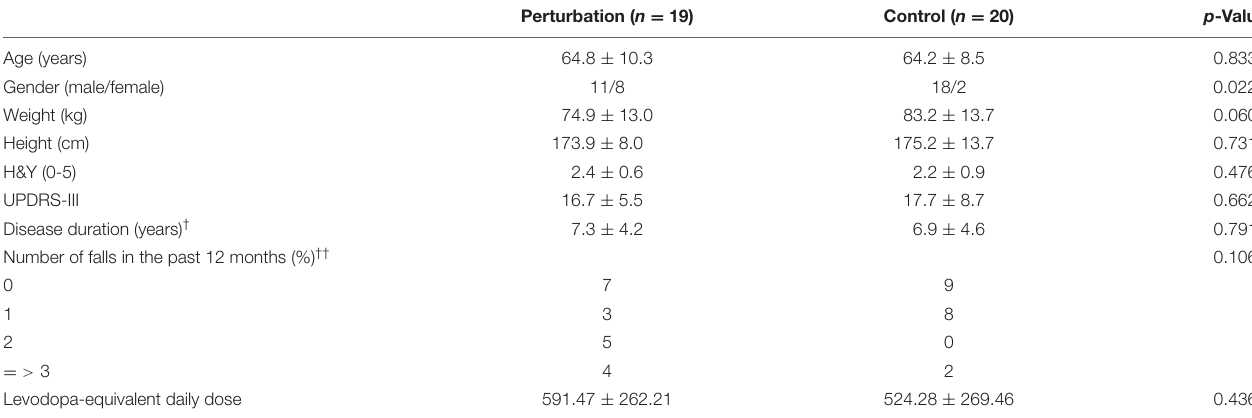
TABLE 1 | Patient characteristics (mean ± standard deviation; † data from n = 27; †† data from n = 38; ∗ p -value < 0.05), modified with permission from Klamroth et al. (2016).